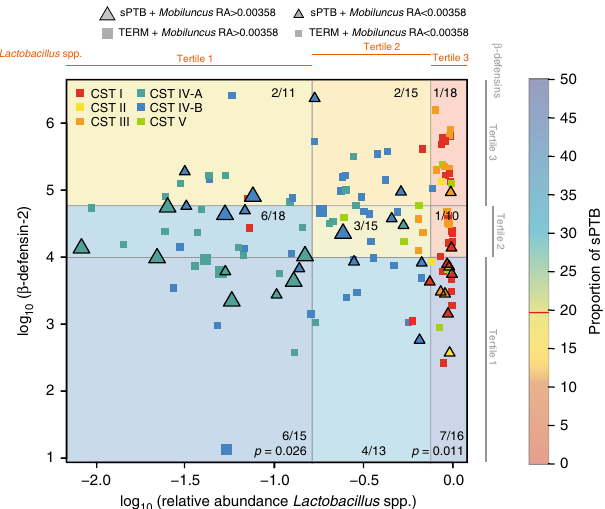
Fig. 3 Interactions between β -defensin-2, Lactobacillus spp. relative abundance, M . curtisii/mulieris relative abundance, vaginal community state types and pregnancy outcomes in AA women at visit 1. Each woman who went on to deliver preterm is represented by a triangle, while those who delivered at term by a square. Large and small triangles or squares are colored by CSTs and indicate relative abundances (RA) of M. curtisii/ mulieris above and below its threshold value, respectively, as de fi ned in Fig. 1. β -defensin-2 concentrations and Lactobacillus spp. relative abundances were strati fi ed into tertiles. The color of each quadrant indicates the proportion of sPTBs (number of sPTB/total births). p -values were estimated using Bayesian binomial models using uniform prior for two proportions implemented in rstan R